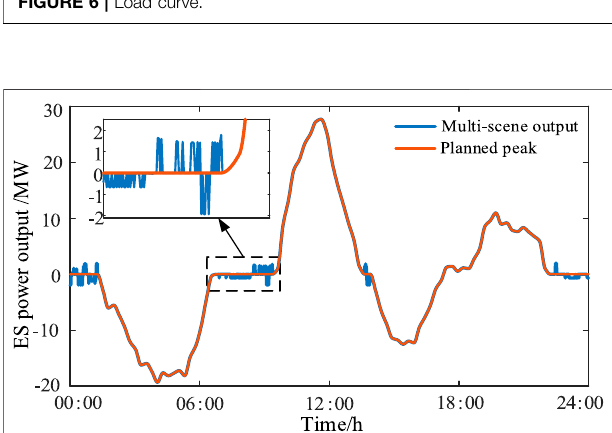
FIGURE 6 | Load curve.